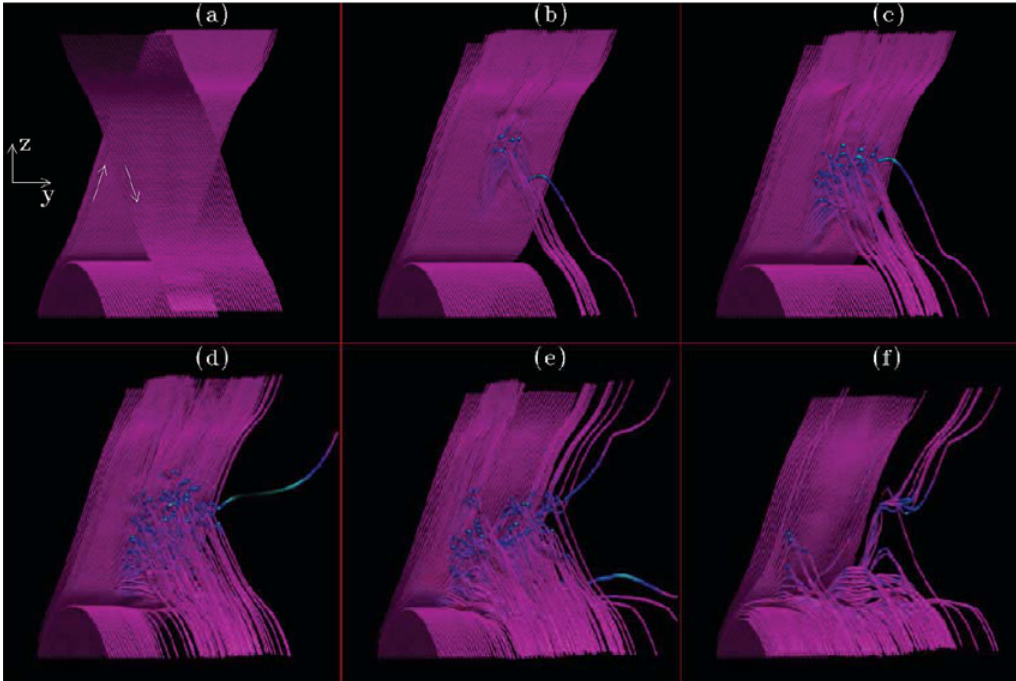
Figure 20. ARMS MHD simulation of solar flare reconnection in a Y-type current sheet, with time increasing from (a) through (f). Magnetic reconnection is initiated by a localized sphere of enhanced resistivity on the current sheet, high in the solar corona. Reconnected loops retract down to the low corona, coming to rest on the pre-existing arcade of loops. This arcade builds up as more magnetic flux reconnects above it, in agreement with observations. The simulation also shows the propagation of reconnection to the left and right of the initial reconnection site, as is observed in the corona, though here the propagation is due to artificial numerical effects